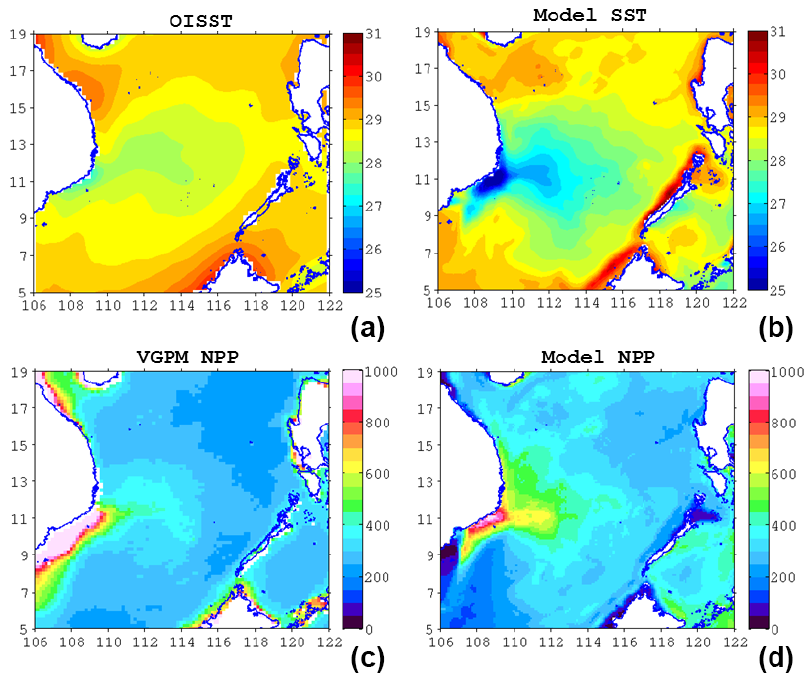
Figure 5. (a) OISST, (b) model SST (unit: ◦ C), (c) VGPM NPP, and (d) modeled NPP (unit: mgCm − 2 day − 1 ) in multi-year August average.